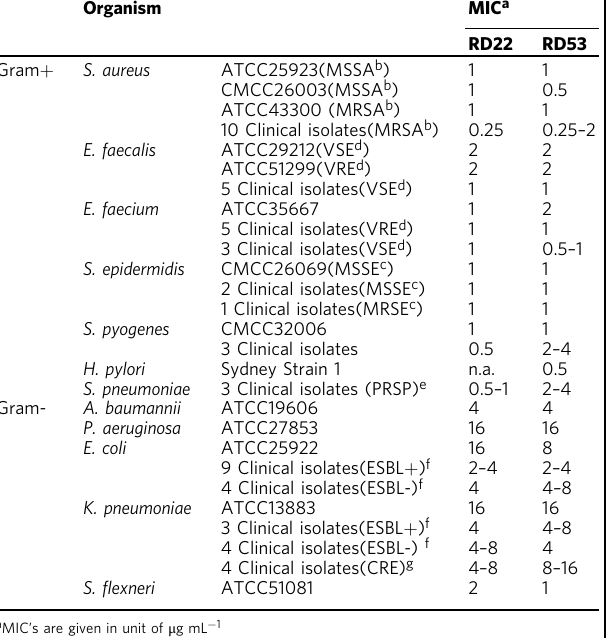
Table 2 Antibacterial activity of RD22 and RD53 against a panel of Gram-positive and Gram-negative pathogens Organism MIC